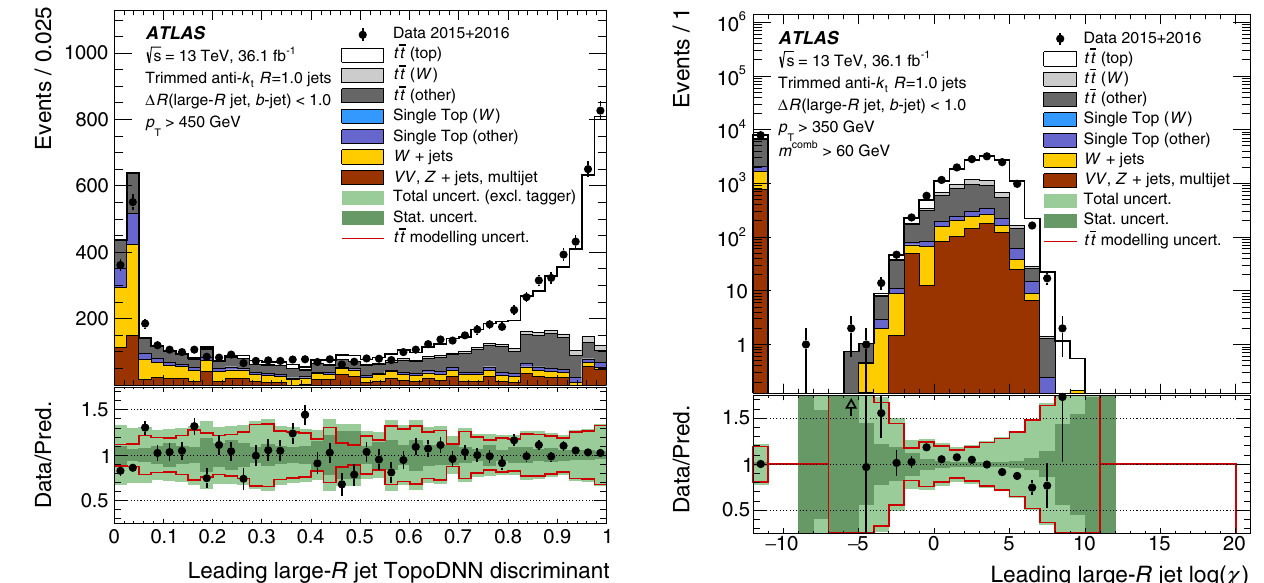
Fig. 14 A comparison of the observed data and predicted MC distribu- tions of the log χ shower deconstruction discriminant for the top-quark event selection in a sample enriched in lepton+jets t ¯ t events. Simulated distributions are normalised to data. The t ¯ t sample is divided into a set of subsamples (e.g. t ¯ t (top)) based on criteriadescribed in Sect.4.2. The ensemble of jets with a large negative log χ value correspond to the set of jets where no subjet configuration is roughly consistent with a top- quark jet topology, as described in Sect. 5.4. The statistical uncertainty of the background prediction (Stat. uncert.) results from limited Monte Carlo statistics as well as the limited size of the data sample used in the data-driven estimation of the multijet